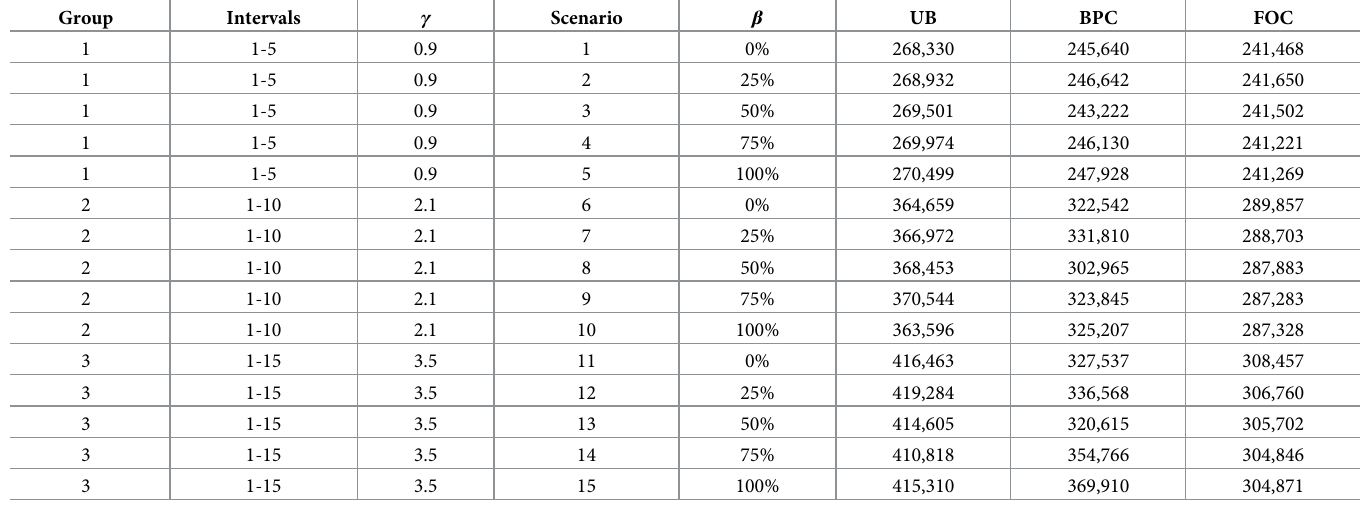
Table 11. Results of the